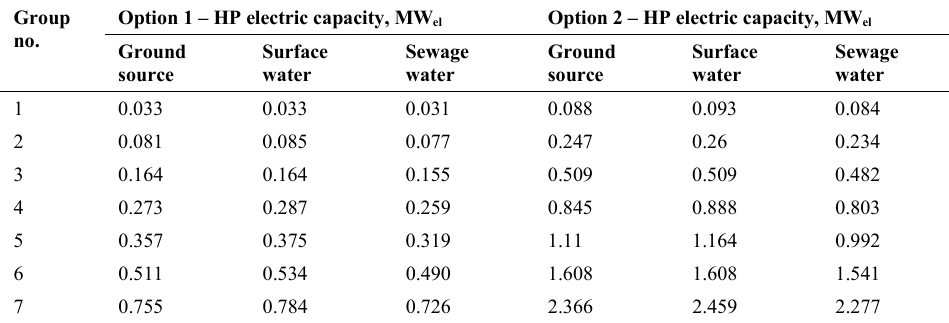
Fig. 2. Average COP for ground source, hydrothermal and sewage water HPs. T ABLE 2. HP E LECTRIC C APACITIES FOR B OTH O